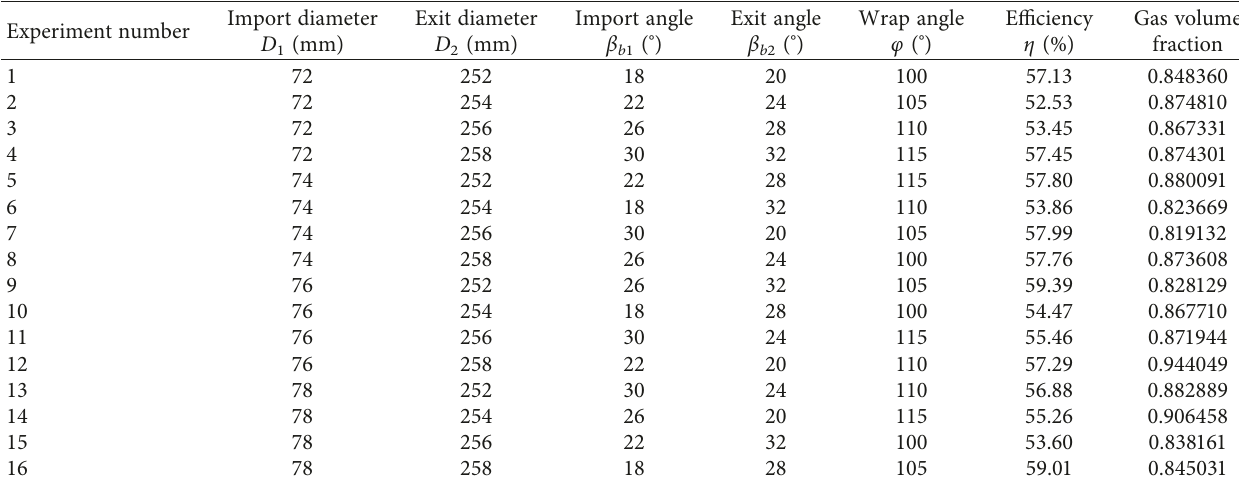
Table 3: Orthogonal experimental results of impeller structure.